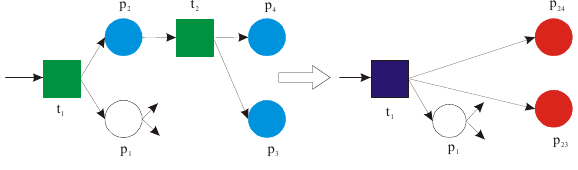
Fig.17. “AND” branch transition reduction The “AND” branch transition reduction process in Fig.17 also can be represented by the service net